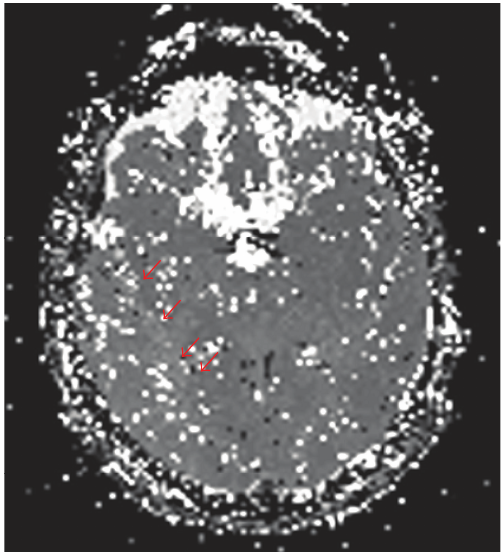
Figure 4: Hypoperfusion in brain area corresponding to the right MCA.